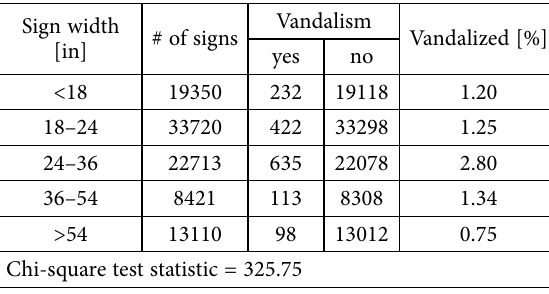
Table 3. Traffic sign vandalism by width